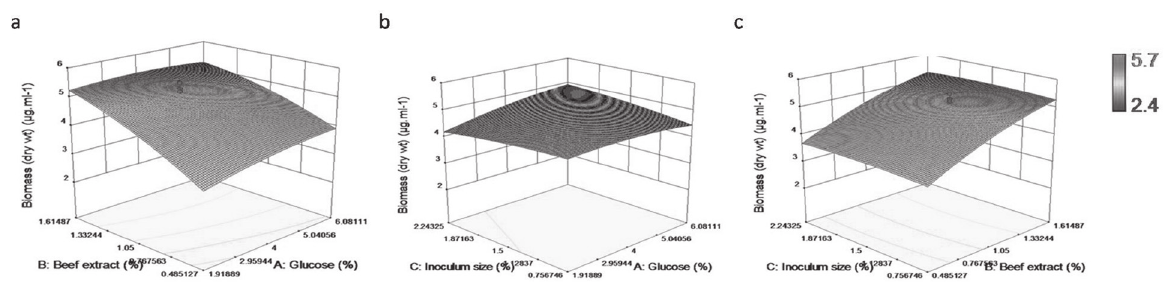
Figure 3 - Response surface graph of B. cereus IB311 production in terms of biomass (dry wt.). a : The effect of glucose and beef extract on B. cereus IB311 production. b: The effect of glucose and inoculums sizes on B. cereus IB311 production. c: The effect of beef extract and inoculums size on B. cereus IB311